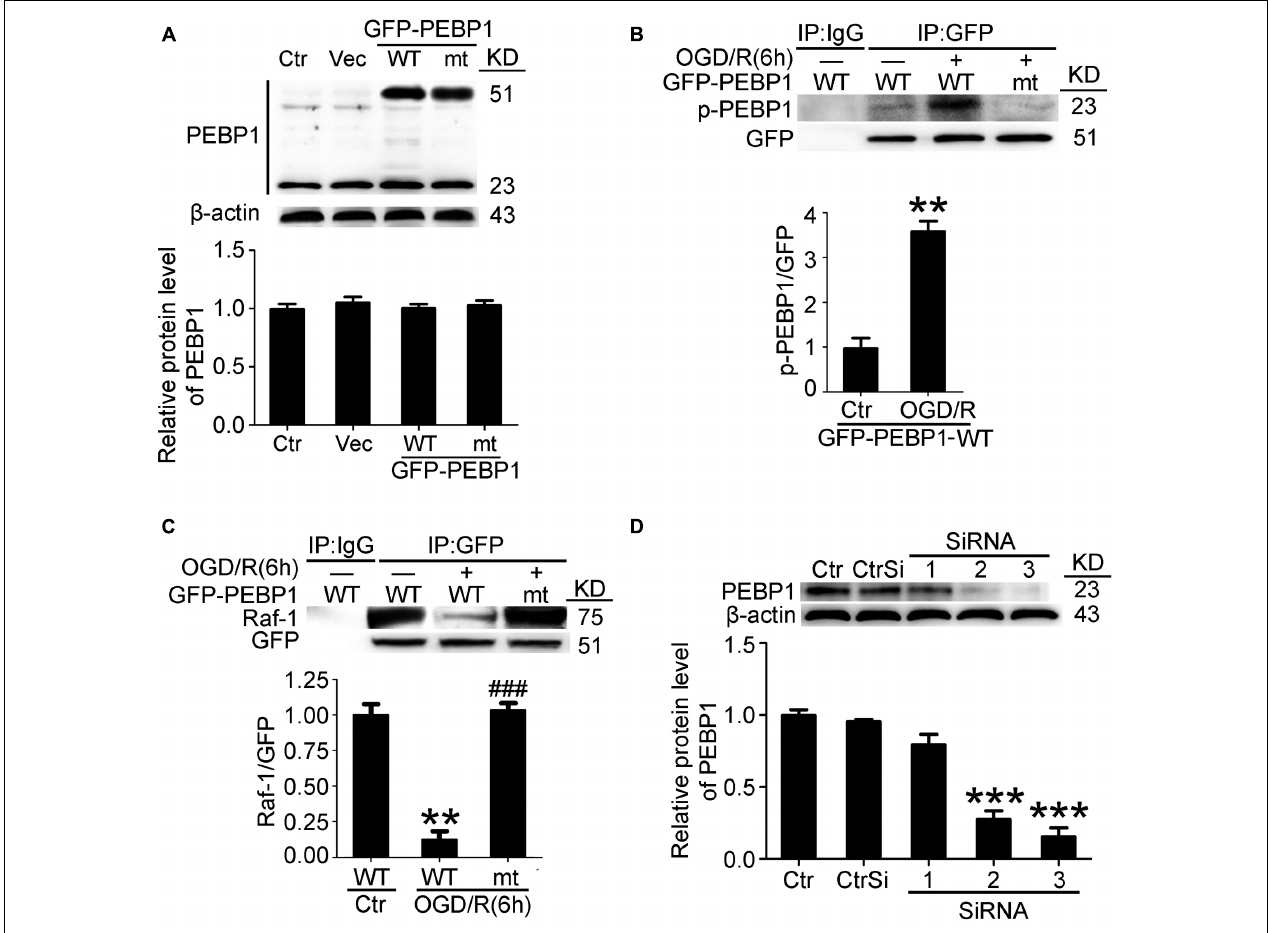
FIGURE 3 | Transfection efficiency of PEBP1 expression vectors and siRNAs and the effect of mutation of serine153 to alanine on PEBP1 phosphorylation and the interaction between PEBP1 and Raf1 in cultured neurons. (A) Neurons were separately transfected with GFP-N2 expression vector (Vec), GFP- wide type PEBP1 (WT) and GFP-PEBP1 (S153A) (MT). Neurons were harvested at 48 h after transfection. Equal amounts of indicated cell lysate proteins were immunoblotted using PEBP1 antibody. The quantitative analysis of the protein level of PEBP1 was shown below and there were no significant changes ( n = 6/group). (B) Western blot and quantitative analysis of the level of p-GFP-PEBP1 in neurons. To test the level of p-GFP-PEBP1 easily, immunoprecipitation (IP) using GFP antibody was performed to enrich GFP-PEBP1 from total proteins before electrophoresis. ∗∗ p = 0.0025 vs. control + GFP-PEBP1-WT group ( n = 6/group). (C) GFP-PEBP1/Raf-1 interaction was determined using IP. Quantitative histogram analysis was performed. ∗∗ p = 0.0012 vs. control + GFP-PEBP1-WT group, ### p < 0.001 vs. OGD/R + GFP-PEBP1-WT group ( n = 6/group). (D) PEBP1 silencing efficiency. ∗∗∗ p < 0.001 vs. control siRNA (CtrSi) group ( n = 6/group). Statistical comparisons between groups were performed using one-way analysis of variance followed by either a Dunnett’s or a Tukey’s post hoc test, the former for comparisons to a single control group, the latter to compare across multiple groups. p-PEBP1: phosphorylated PEBP1 at Ser153; WT: wild type; MT: PEBP1 with Ser153 mutated to